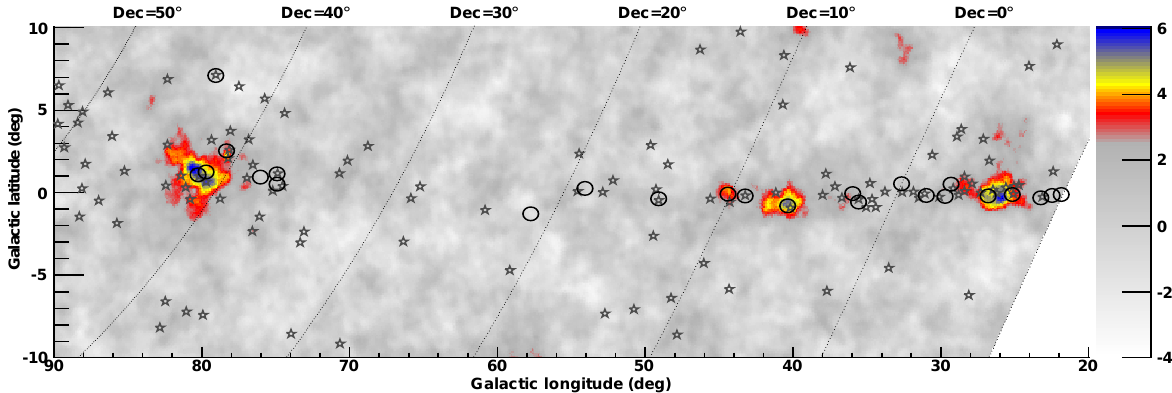
Figure 3: Significance map of the Galactic Plane region with | b | < 10 ◦ and 20 ◦ < l < 90 ◦ obtained by the ARGO-YBJ experiment. The circles indicate the position of all the known VHE sources. The open stars mark the location of the GeV sources of the second Fermi -LAT